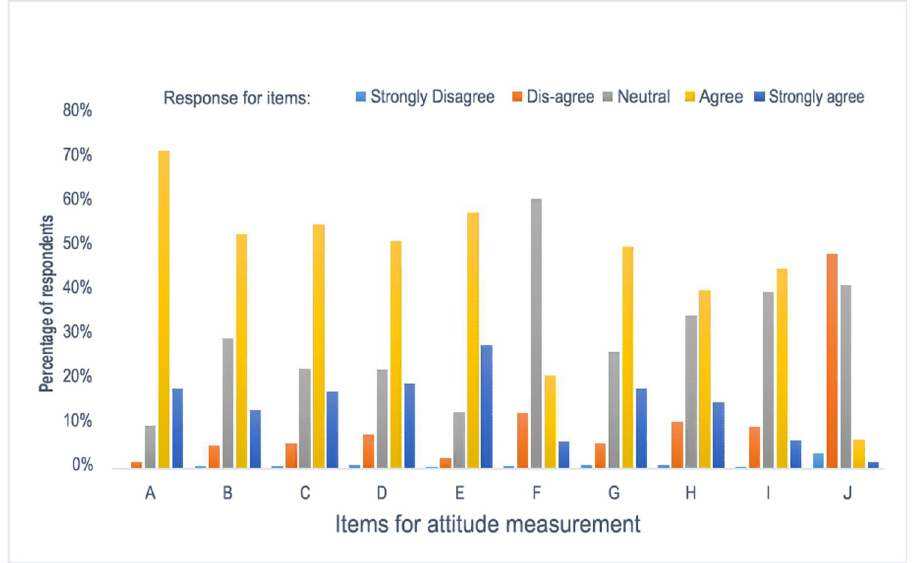
Fig 7. Self-reported attitudes towards evidence-based practice among nurses in the University of Gondar and Tibebe Gion teachings specialized hospitals, Ethiopia 2020.